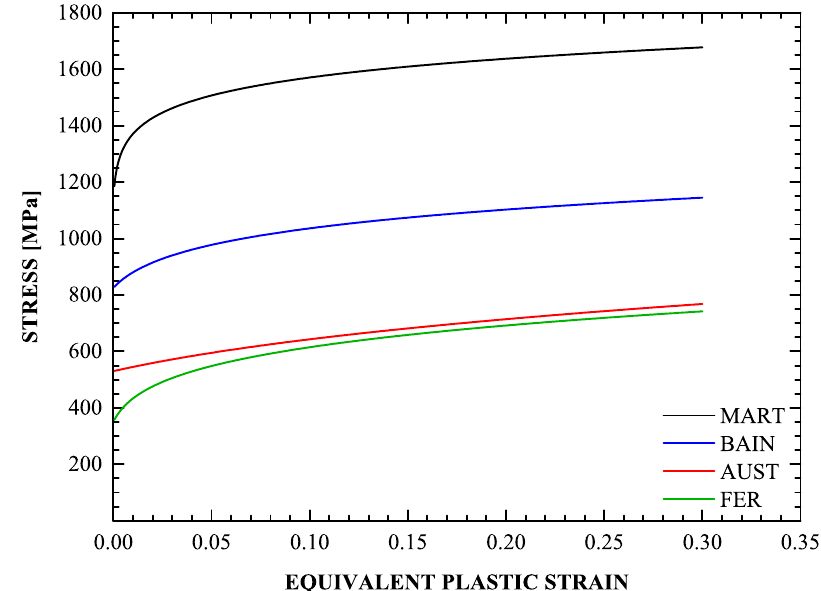
Figure 10. Hardening behavior of the constituent phases for the four-phase TRIP steel. Experiments